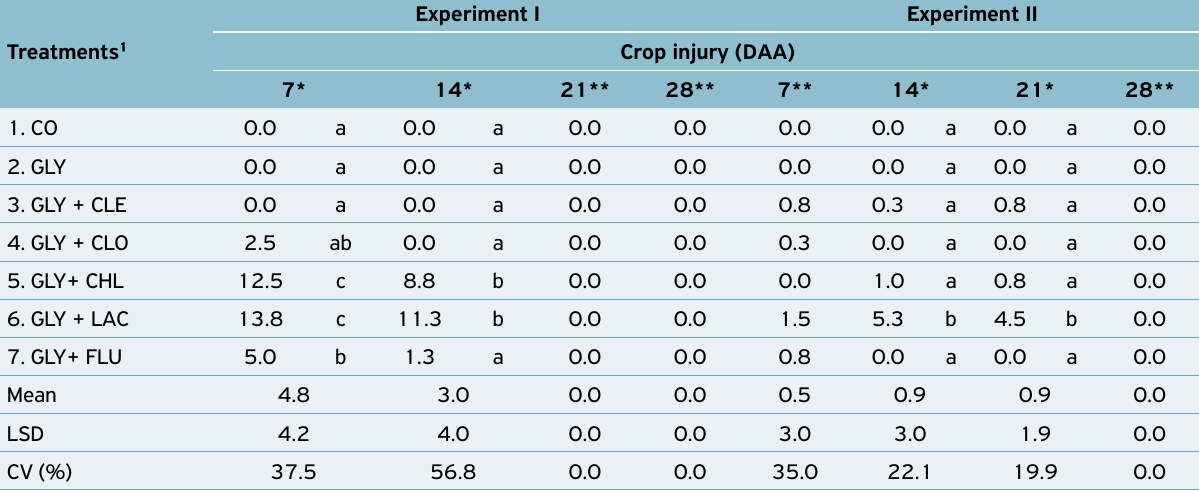
Table 3. Crop injury (%) at 7, 14, 21 and 28 days after application of RR2 soybean subjected to application of glyphosate, alone or in combination, at post‑emergence (V4). Piracicaba, state of São Paulo, 2013/14 season (experiment I), and 2014/15 season (experiment II).